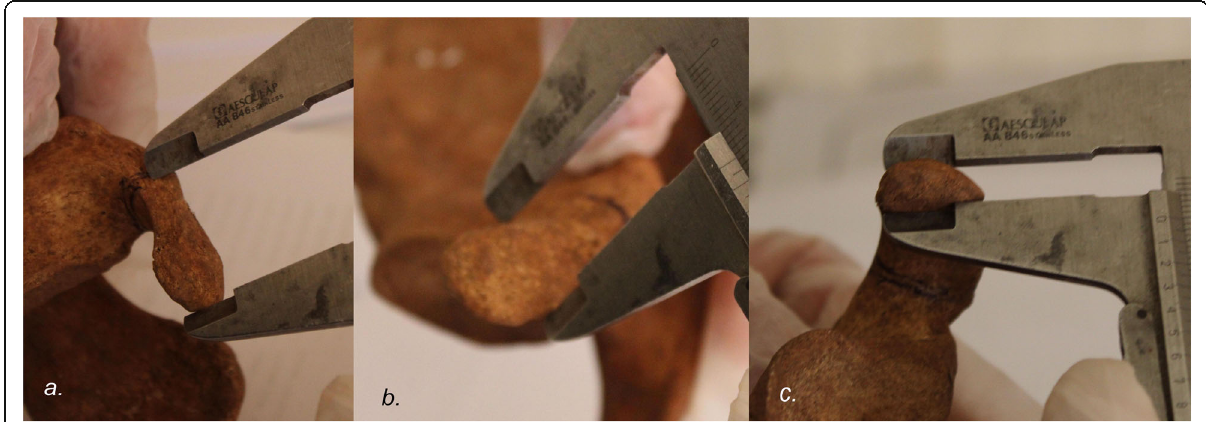
Fig. 2 The coracoid ( a ) anterior-posterior (coracoid length - CL), ( b ) medial-lateral (coracoid width - CW) and ( c ) superior-inferior (coracoid thickness - CTh) are measured